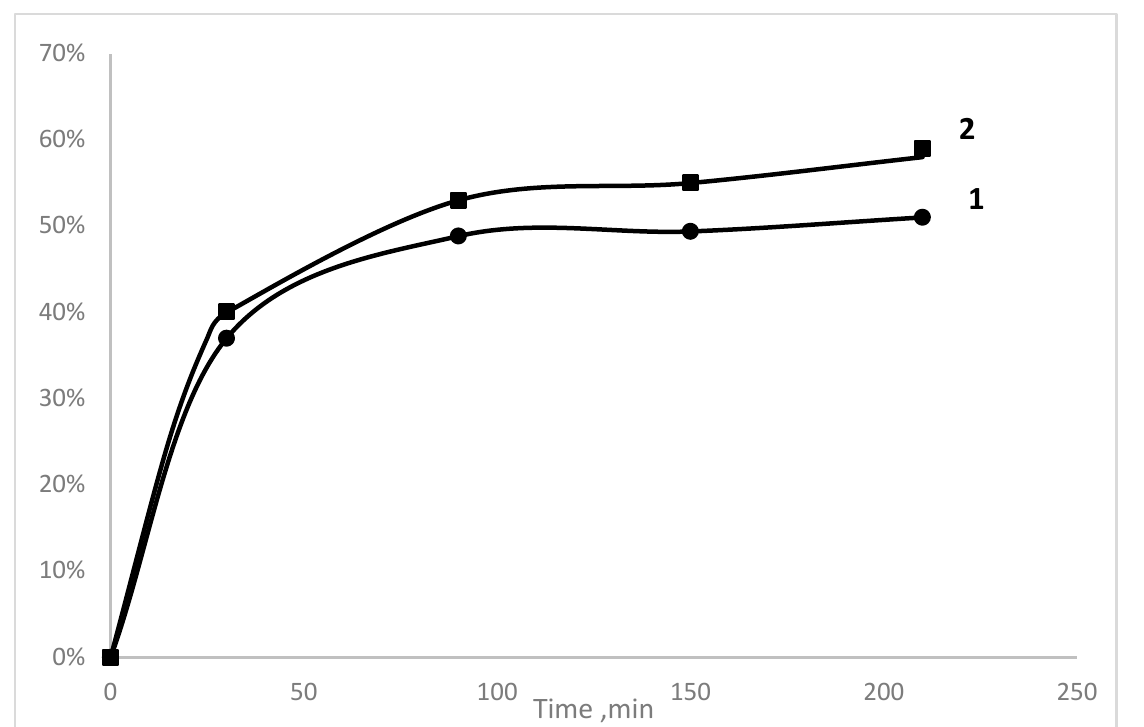
Table 3. Catalytic performance and recyclability of the Au@meso-UiO-66 nanohybrid in the reaction of condensation of acetophenone and aniline.